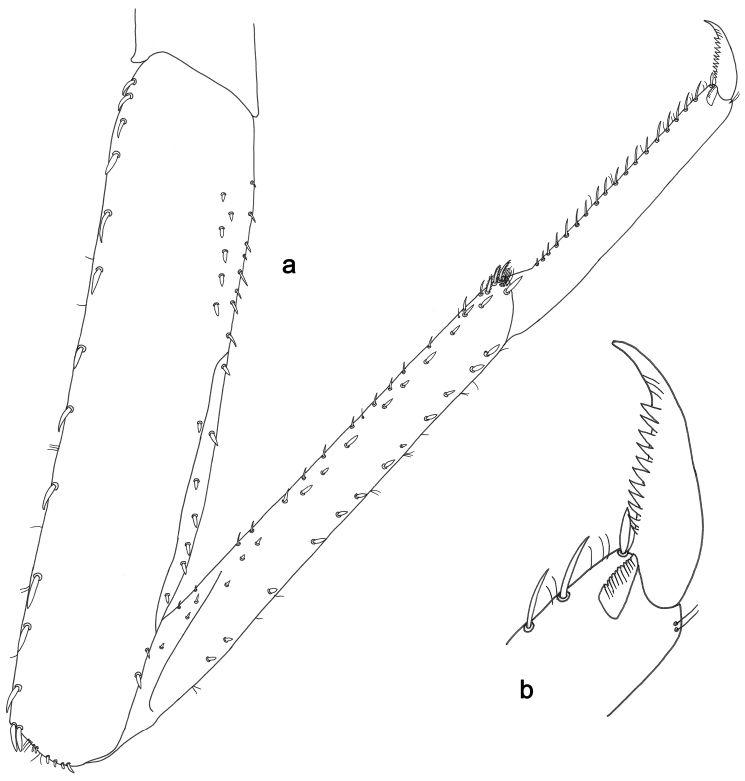
Labiobaetisinopinatus sp. n., larva morphology: aForelegb Fore claw.